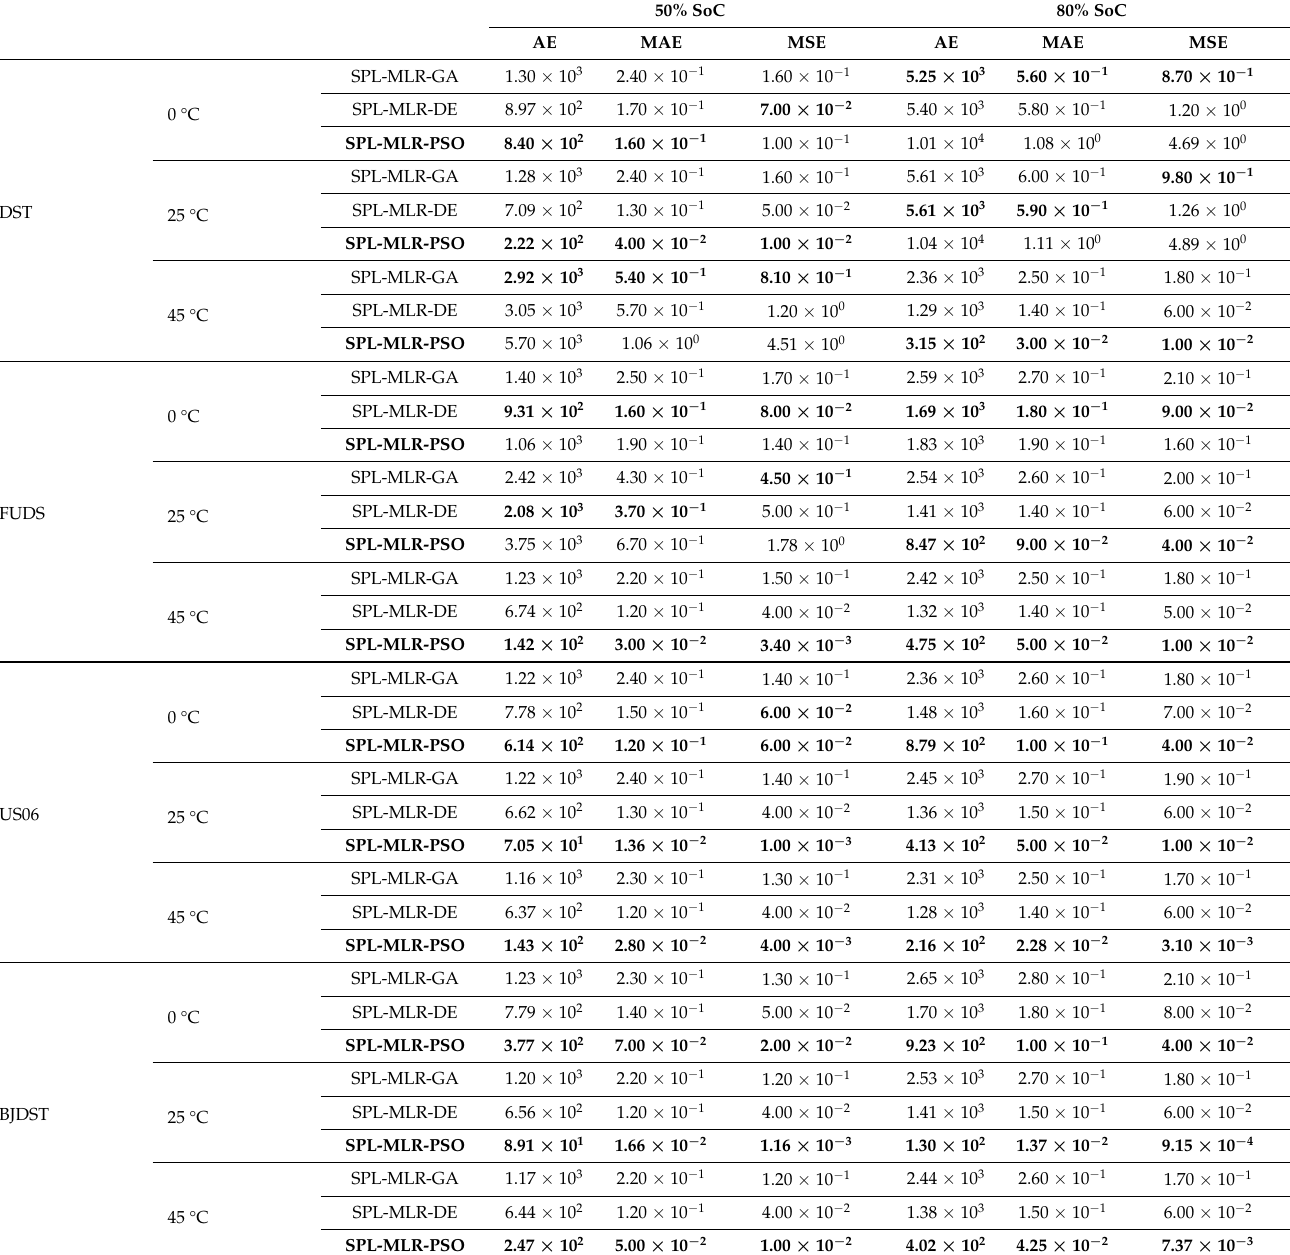
Table 4. Test results for all profiles at different SoC and temperatures for the SPL-MLR